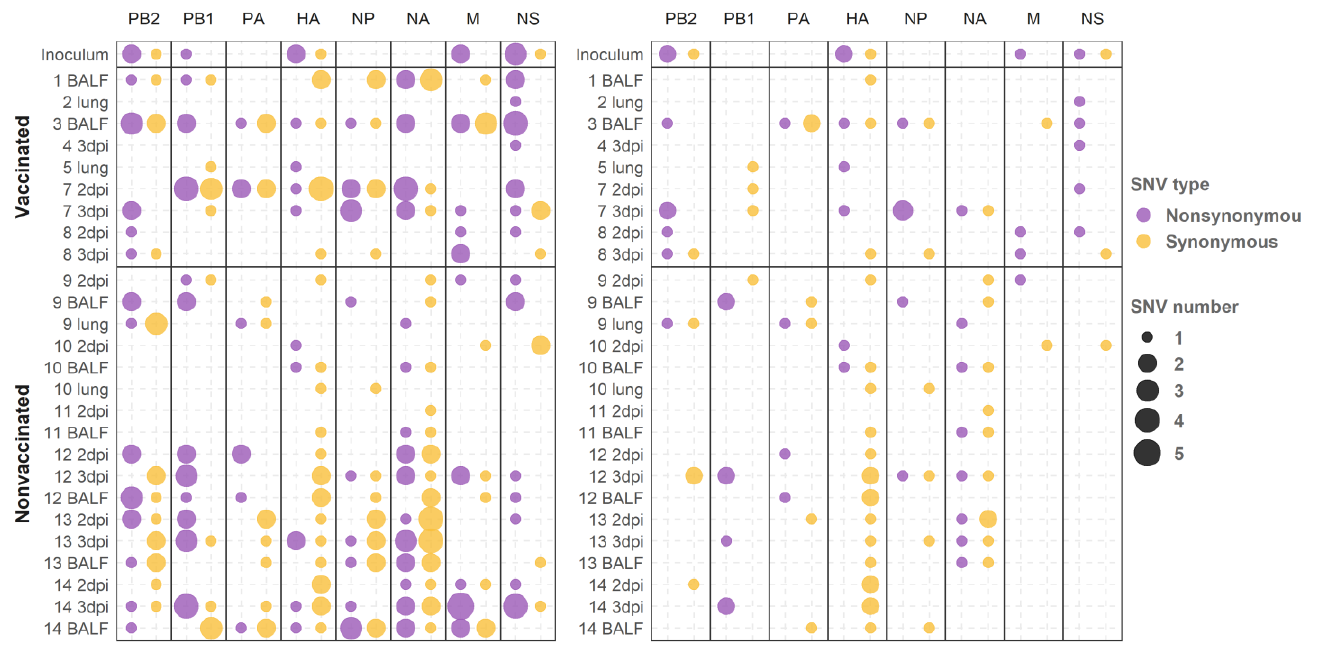
Figure 4. Genome segment distribution and number of synonymous and nonsynonymous SNVs found from sequenced samples from vaccinated and nonvaccinated animals. ( left ) Substitutions with an allele frequency greater than 1%. ( right ) Substitutions with an allele frequency greater than 5%.